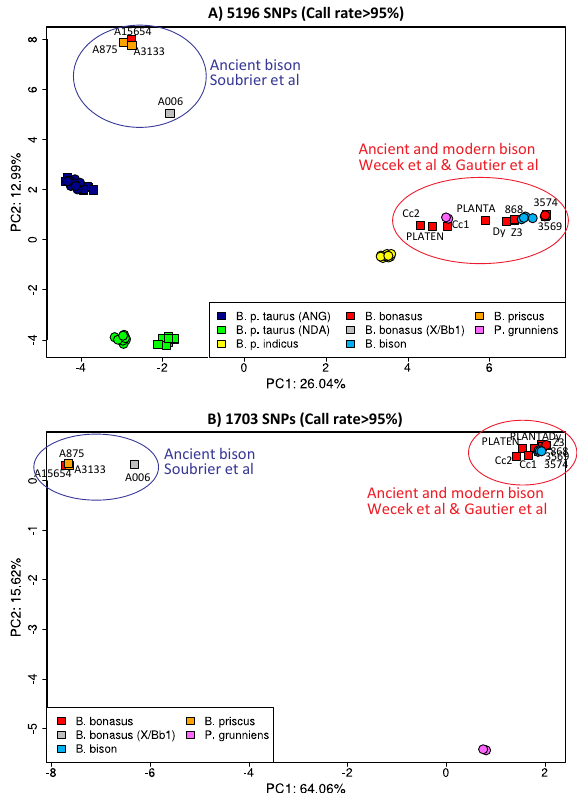
Figure 7. Principal component analysis of the combined autosomal SNP data of Bovini. The meta-analysis combines SNP data that originate from three different experiments: (i) sequence capture of the loci represented on the BovineSNP50 chip for four individuals [11]; (ii) whole genome sequencing (WGS) of 29 individuals [7,9,32]; and (iii) genotyping with the Illumina BovineSNP50 and Bovine HD BeadChip (Illumina) [37] (see Material and Methods). In total, the combined data set consists of genotypes for 7572 SNPs on 68 individuals among which three bison were genotyped in two different ways: (i) the present-day B. bonasus individuals 3569 and 3574 [7] genotyped with both the BovineHD Illumina BeadChip and using WGS data; and (ii) a 1911 Caucasian sample analyzed in Soubrier et al. [11] under the ID A15654 that is identical to Cc1-8853 sequenced to 1X coverage by Wecek et al. [9]. In PCA plots, individuals whose data originate from WGS data are represented with square, whereas circles were used for SNP-chip genotyping data. ( A ) PCA on the whole data set retaining only the 5196 SNPs that were called in at least 95% of the samples. Note that the positioning of the individuals genotyped with the Illumina assay and using WGS data are consistent since all Angus (ANG) individuals cluster together, as well as the two Bison bonasus individuals 3569 and 3574. In contrast, in accordance with their known variable proportion of indicine ancestry [33], N’Dama (NDA) individuals genotyped with the BovineHD assay separate from those genotyped using WGS [33] that are closer to the B. p. indicus individuals. ( B ) PCA on the data set without the bovine individuals and retaining only the 1703 SNPs that were called in at least 95% of the